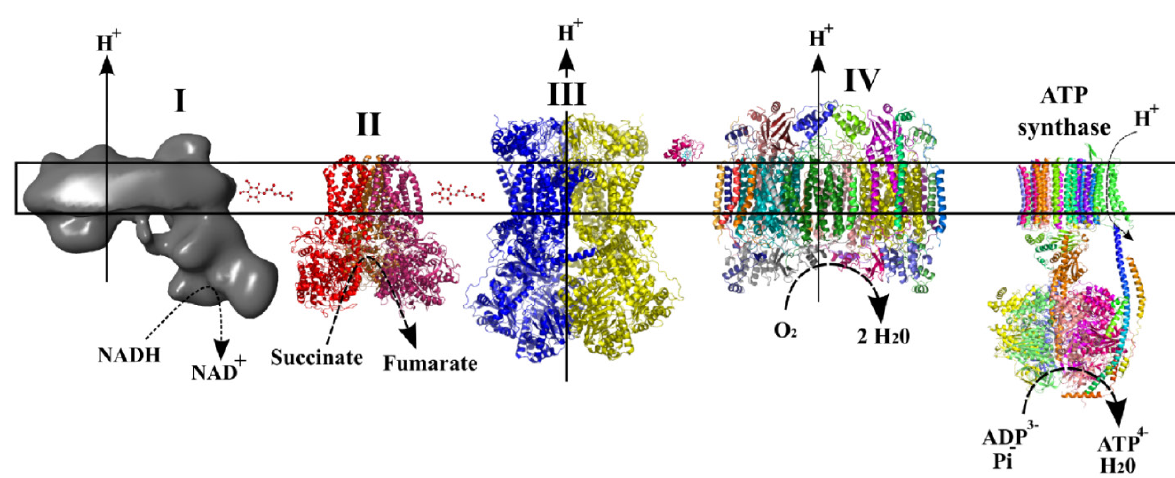
Figure 2: The Mitochondrial Electron transport chain and ATP synthase.The Electron transport chain composed of four different multi- subunit complexes transfer electrons (e- ) in a sequential manner ultimately reducing O proton translocation outdoor into the matrix via three of the four complexes (I, III and IV). Protons gather and create an electrochemical gradient throughout the inner mitochondrial membrane. This osmotic potential is used to power ATP synthesis when protons re-enter the mitochondrial matrix through ATP synthase